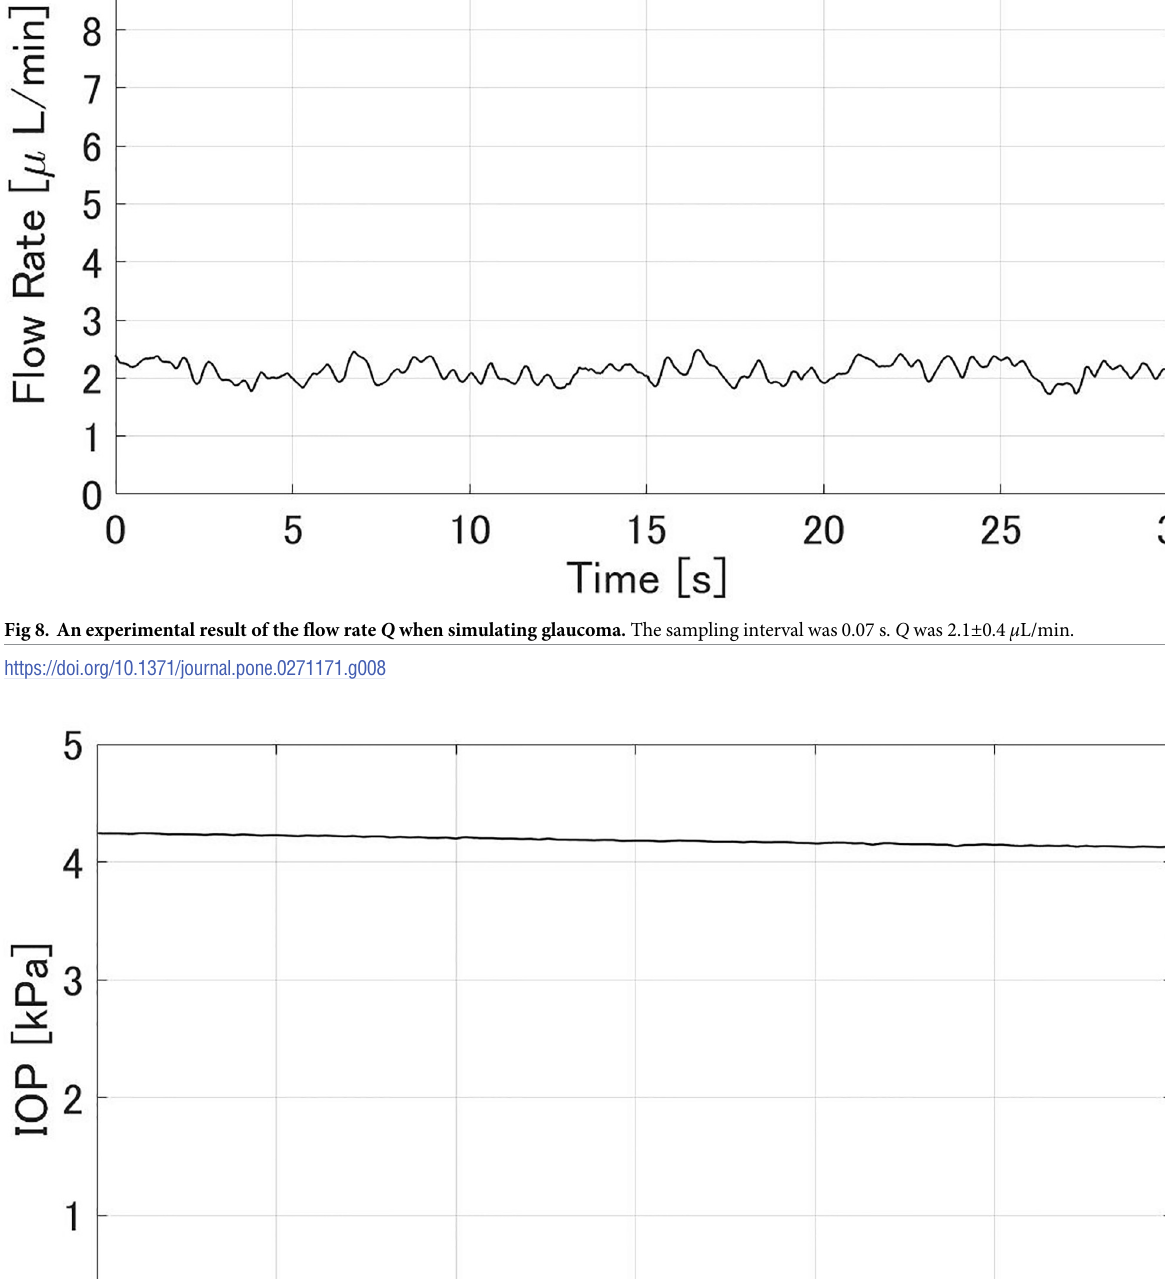
PLOS ONE | https://doi.org/10.1371/journal.pone.0271171 July 11,